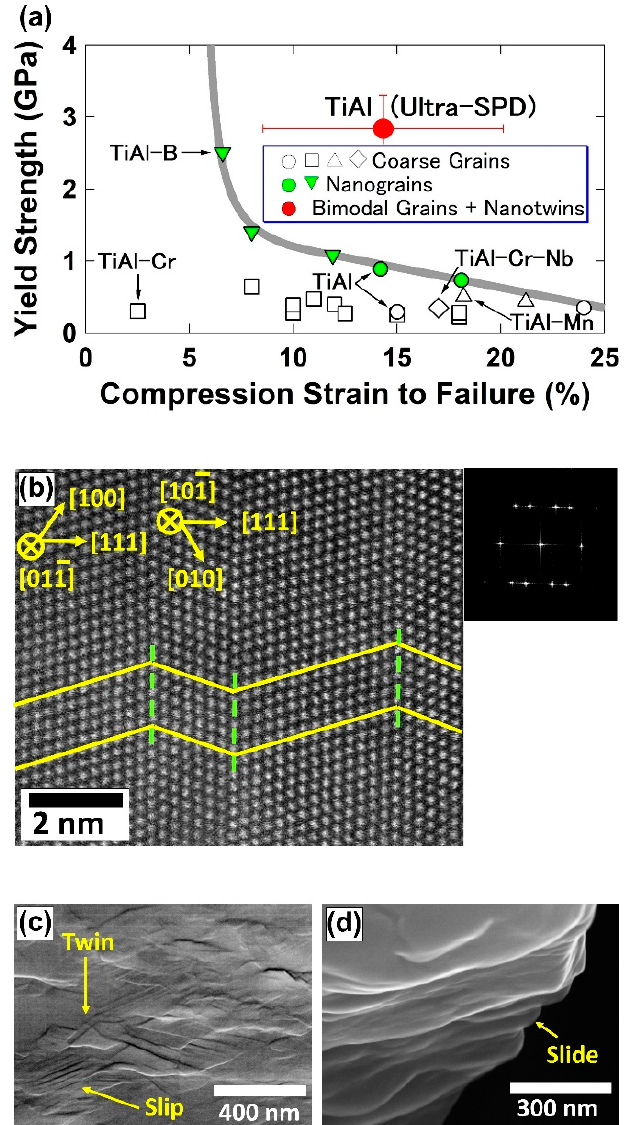
Figure 4. High strength and high plasticity in TiAl intermetallic after ultra-SPD. ( a ) Yield strength versus compression strain to failure for TiAl synthesized by ultra-SPD and low-temperature annealing in comparison with reported data for coarse-grained and nanograined TiAl alloys. ( b ) Formation of nanotwins in TiAl after ultra-SPD and annealing. ( c , d ) Activation of different deformation mechanisms observed by scanning electron microscopy on surface of TiAl specimen after compression test [35].